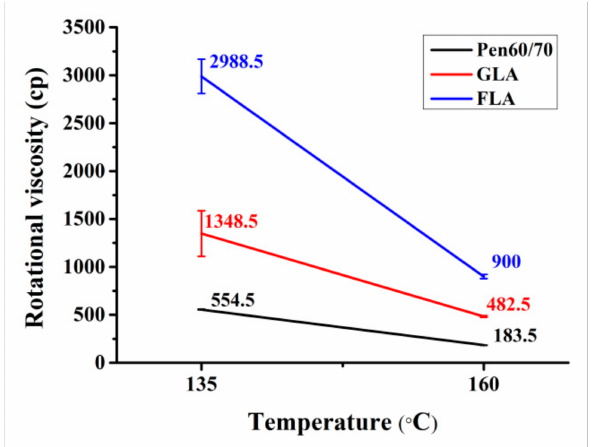
Figure 3. Rotational viscosity test results.